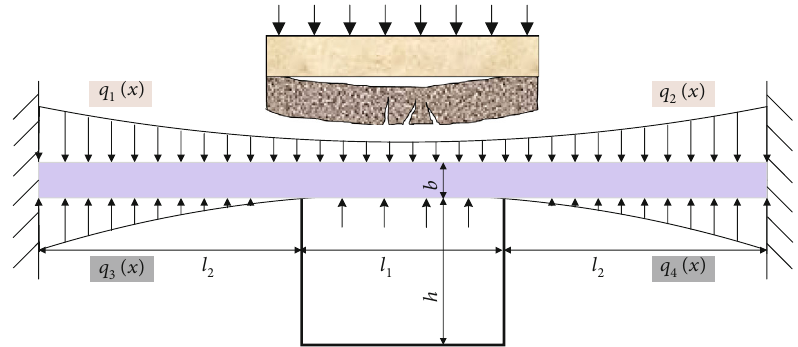
Figure 1: Stress diagram of roof rock